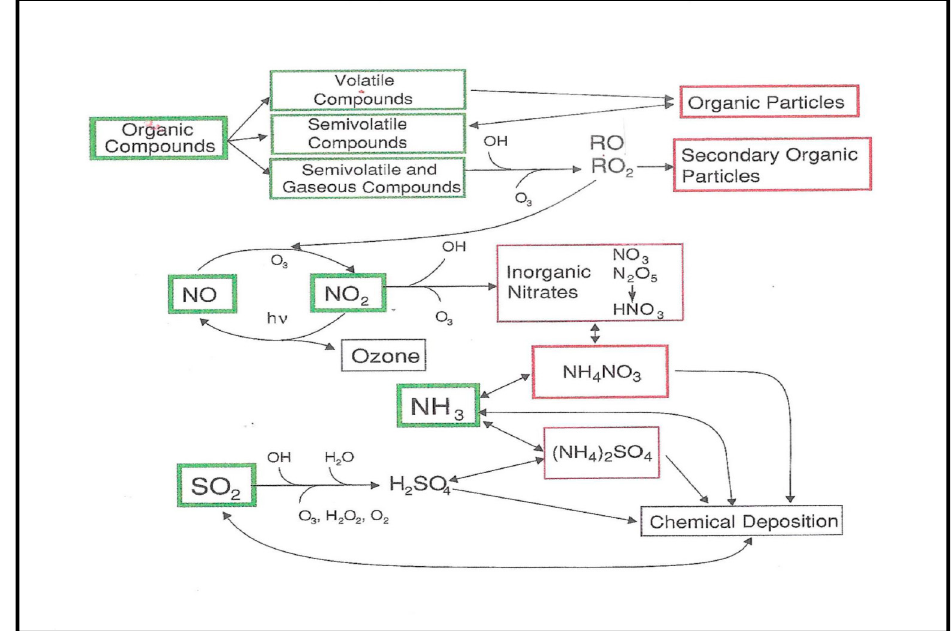
Figure 6. Interaction between the photochemical processing to form O 3 and other oxidants through the VOC-NO x system combined with aerosol formation through SO 2 , NO y and VOC species. SOA chemical deposition is not included in the diagram (reproduced from [191], with permission of the Licencor through PLSclear).